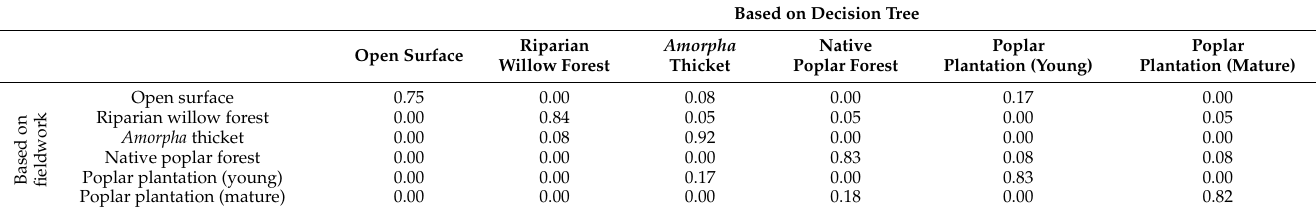
Table 3. The validation confusion